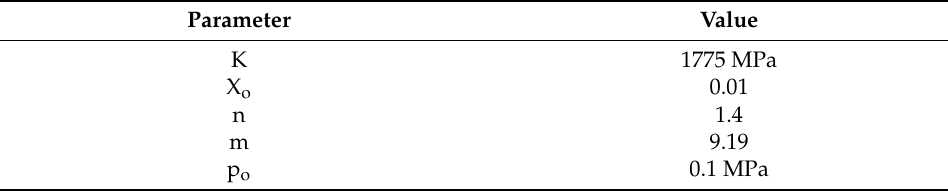
Table 2. Liquid parameters for calculation the K Z ( p ) [12,30].